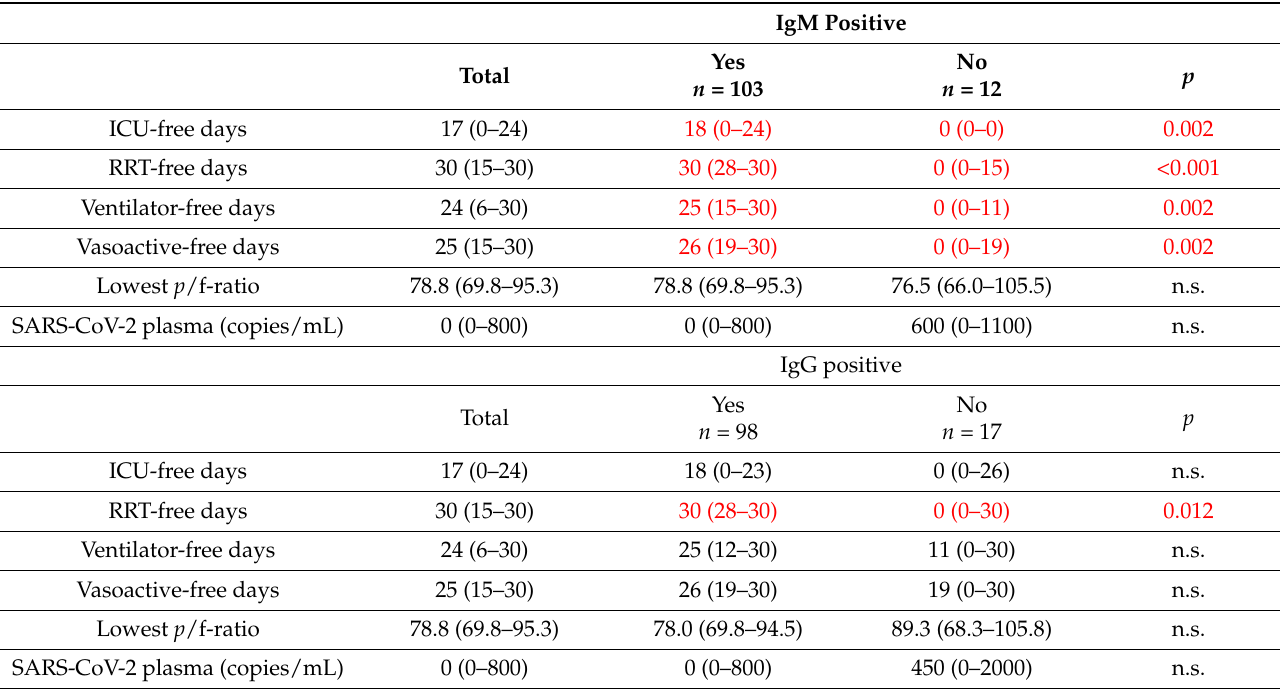
Table 3. Organ support in relation to positivity for anti-SARS-CoV-2